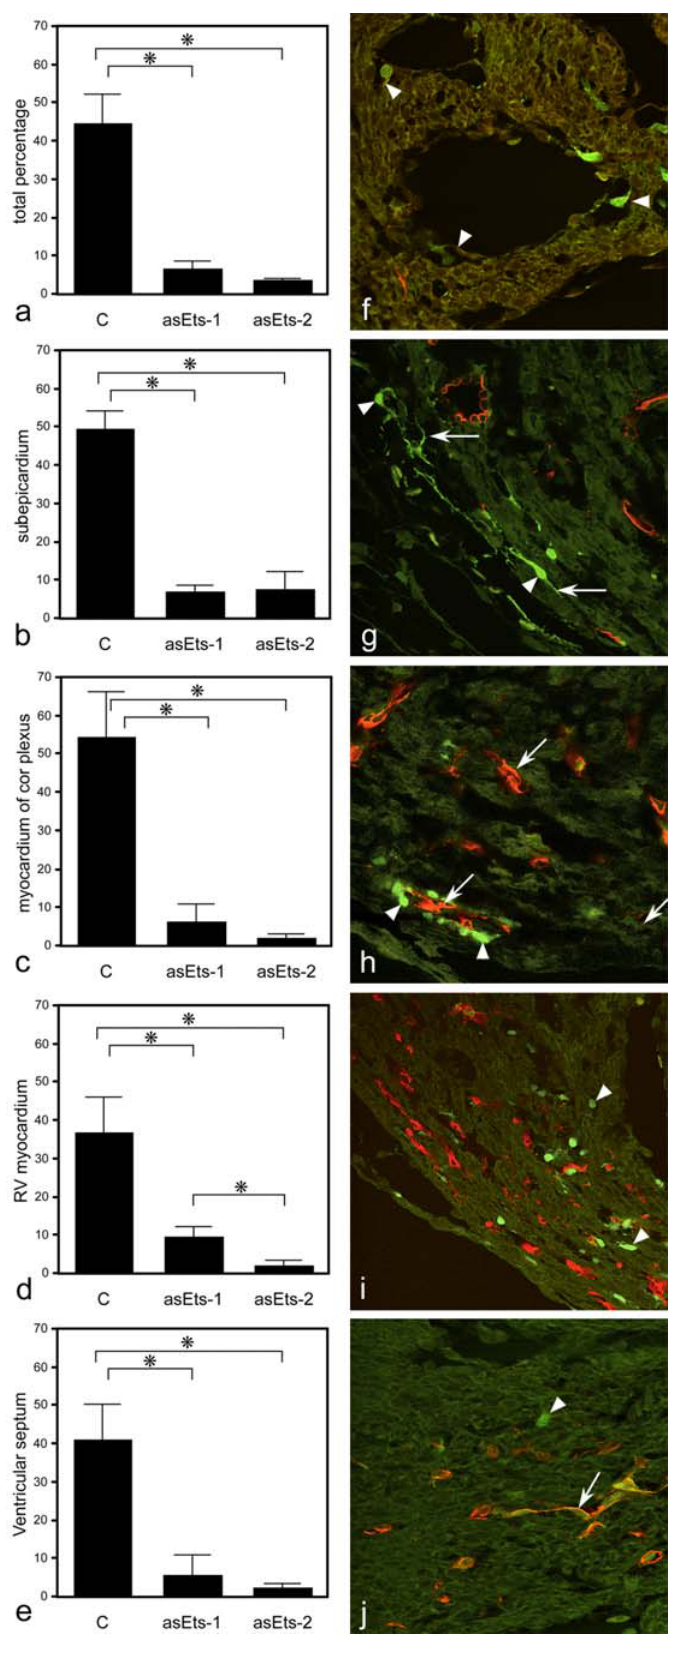
FIGURE 2. Ets-1 and Ets-2 transcription factors are important for the migratory potential of EPDCs. Quail-chicken chimeras (HH35; ED 8.5) in which the transplanted PEO was transduced with a lentiviral construct harboring either a CMV-GFP, a CMV-GFP-asEts-1, or a CMV-GFP-asEts-2 expression cassette were analyzed by light and confocal microscopy. Compared to the EPDCs that were transduced with the control CMV-GFP lentivirus, EPDCs expressing either GFP-asEts-1 or GFP-asEts-2 were found in severely reduced total numbers in the heart. (a) Similar statistically significant (*) differences were found between EPDCs harboring the control and antisense constructs in selected regions of the heart: the subepicardium (b,g), the myocardium in which the coronary plexus develops (c,h), the myocardial wall of the right ventricle (d,i), and the myocardium of the ventricular septum (e,j). The Y- axis in the left panels represents the number of GFP-positive cells as a percentage of the total amount of quail-derived QCPN-positive cells. Tha t GFP expression did not affect the normal migration potential of the EPDCs is shown in green in the confocal photomicrographs in the right panels (f–j). GFP-positive EPDCs were observed at subendothelial trabecular sites (arrowheads in f), in the subepicardium (arrowheads in g) where the GFP marker highlights the migratory processes of the mesenchymal EPDCs (arrows in g), in the walls of the coronary arteries (arrowheads in h), as interstitial cells of the ventricular myocardial wall (arrowheads in i), and in the ventricular septum (arrowheads in j). Although the transduced proepicardial explants contained a tiny piece of liver for the delivery of endothelial (precursor) cells, GFP expression hardly ever colocalized with the quail-specific endothelial marker QH1 (red; arrows in h). Only in the ventricular septum occasional double-staining of GFP-positive endothelial cells was observed (yellow signal indicated by an arrow in